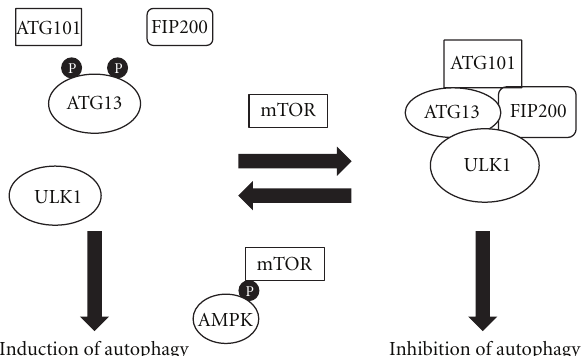
Figure 6: mTOR and AMPK regulation of macroautophagy. During nutrient rich conditions, mTOR remains active, phosphorylating ATG13, preventing its ability to form the large activating complex for autophagy (ATG13-FIP200-ULK1-ATG101). During periods of nutrient deprivation (amino acid deprivation, growth factor deprivation, and/or low-energy status), AMPK is activated and phosphorylates mTOR, preventing its ability to phosphorylate ATG13. This allows ATG13 to form the large activating complex, leading to the induction of autophagy. ATG: autophagy-related protein; P: phosphate; AMPK: adenosine monophosphate kinase; FIP200: focal adhesion kinase family- interacting protein of 200 kDa; ULK1: Unc-51-like kinase 1; mTOR: mammalian target of